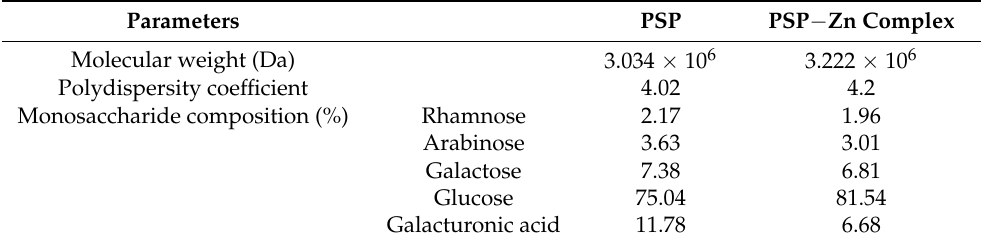
Table 2. The molecular weight and monosaccharide composition of PSP and PSP − Zn.